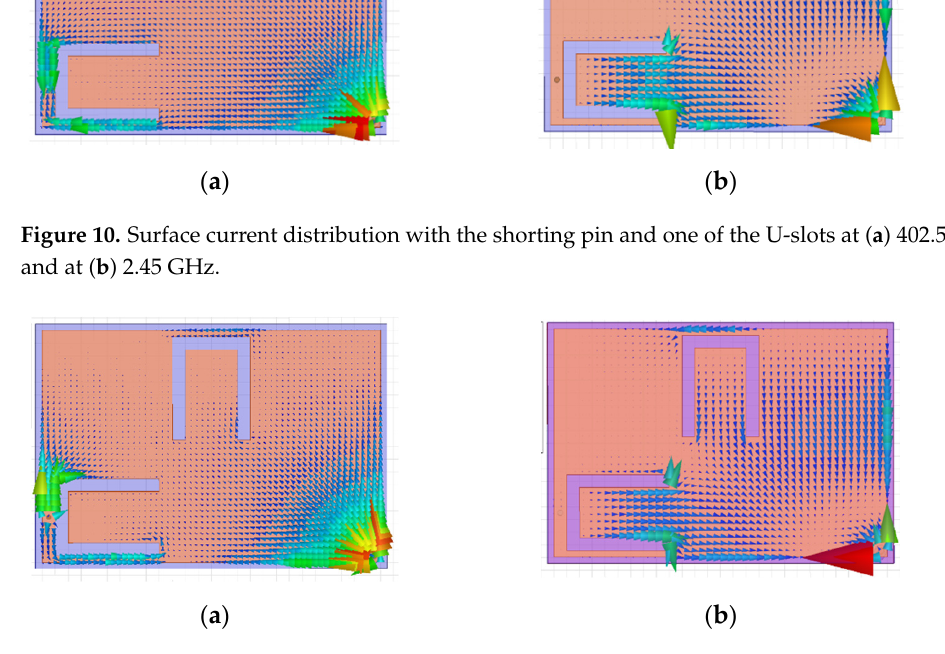
Figure 11. Surface current distribution of the final antenna design at ( a ) 402.5 MHz and at ( b ) 2.45 GHz.